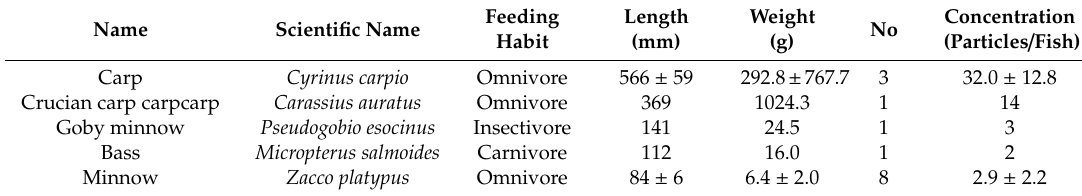
Table 1. Feeding habit, length, weight, and number of fishes used in this study and concentration of microplastics in the